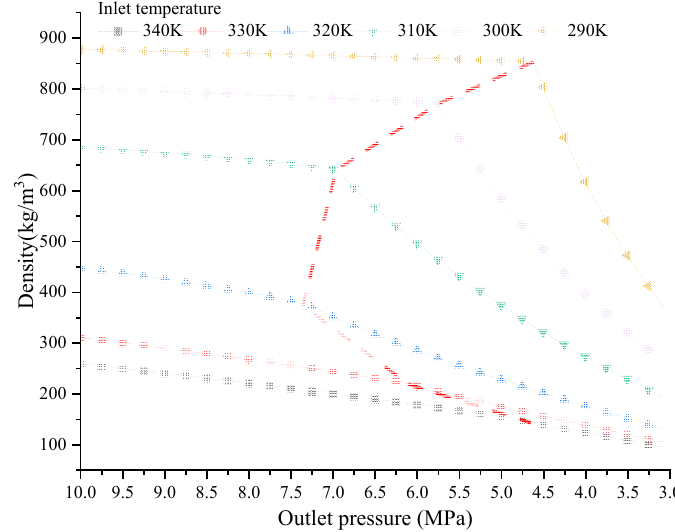
Figure 19. Curve of density with change of outlet pressure and inlet temperature.